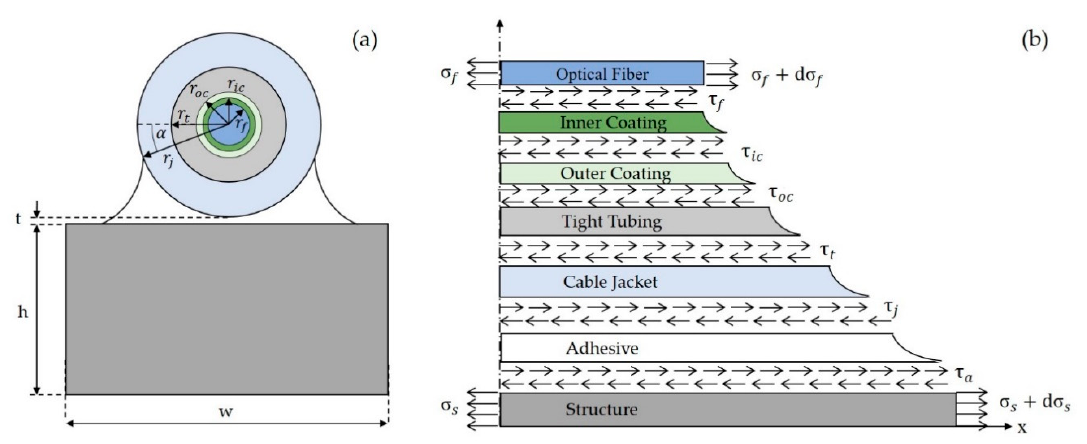
Figure 2. Multilayered model for the two cable prototypes. Cross section ( a ), free body diagram of an infinitely small cable segment ( b ).